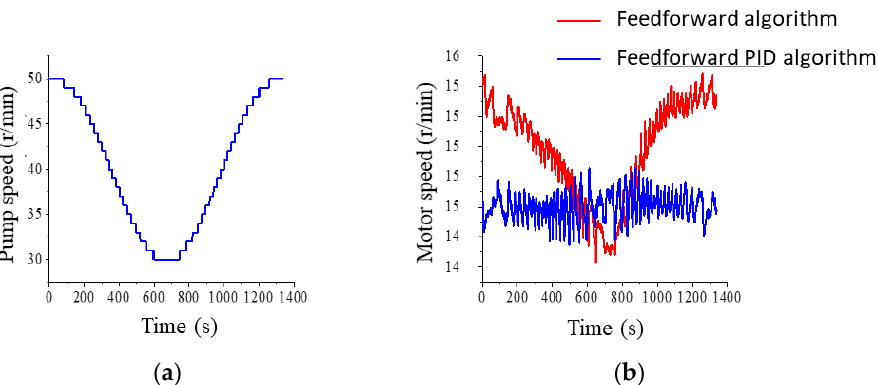
Figure 13. Experimental curve of rotational speed change. ( a ) Hydraulic pump speed change input signal, ( b ) Hydraulic motor speed output signal.